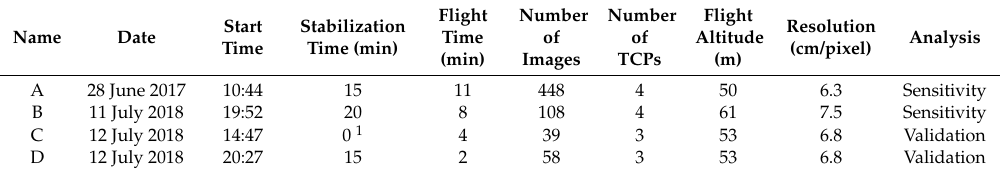
Table 1. UAV flights conducted with the Vue Pro, including stabilization time of the camera before flight, number of temperature calibration plates (TCPs) used for calibration, number of images used for orthomosaic creation, flight altitude above ground level, and type of data analysis